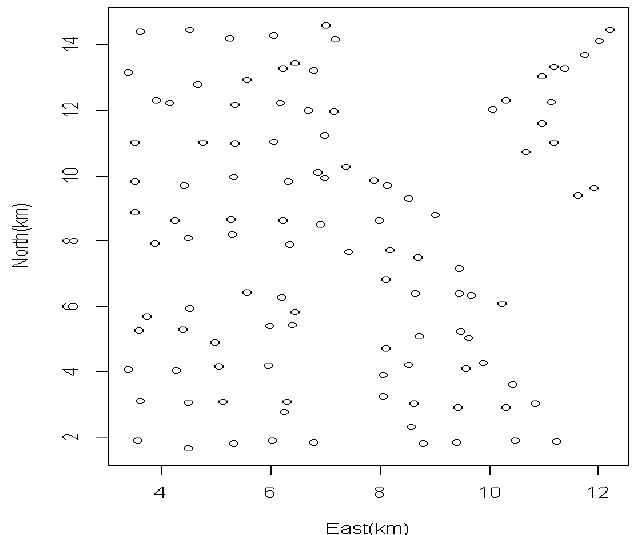
Figure 1. Spatial distribution of sampling sites in the validation strip area.